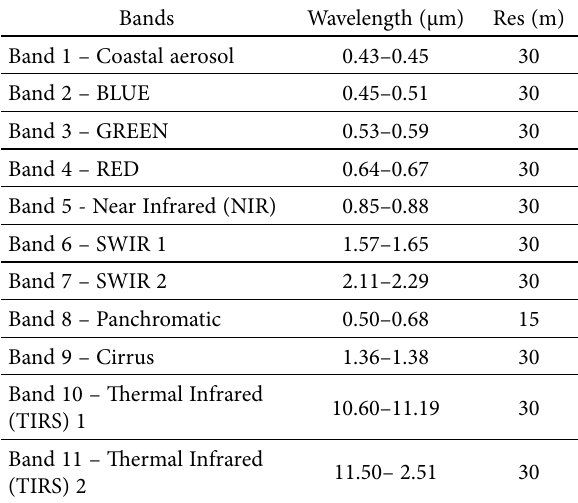
Table 1. Landsat 8 OLI and TIRS